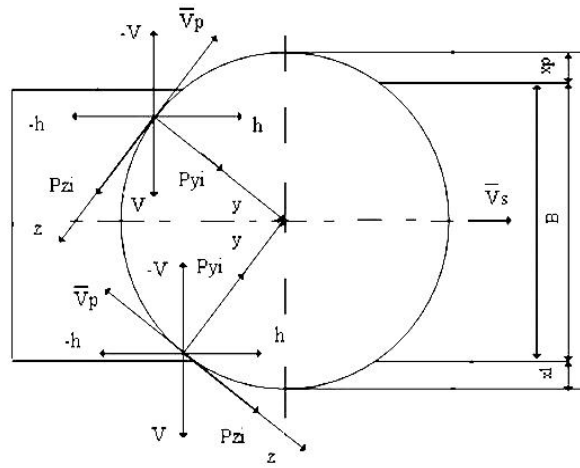
Fig. 2. Scheme of mutual position of the tool and the workpiece, as well as the coordinates of the simulated force parameters during face